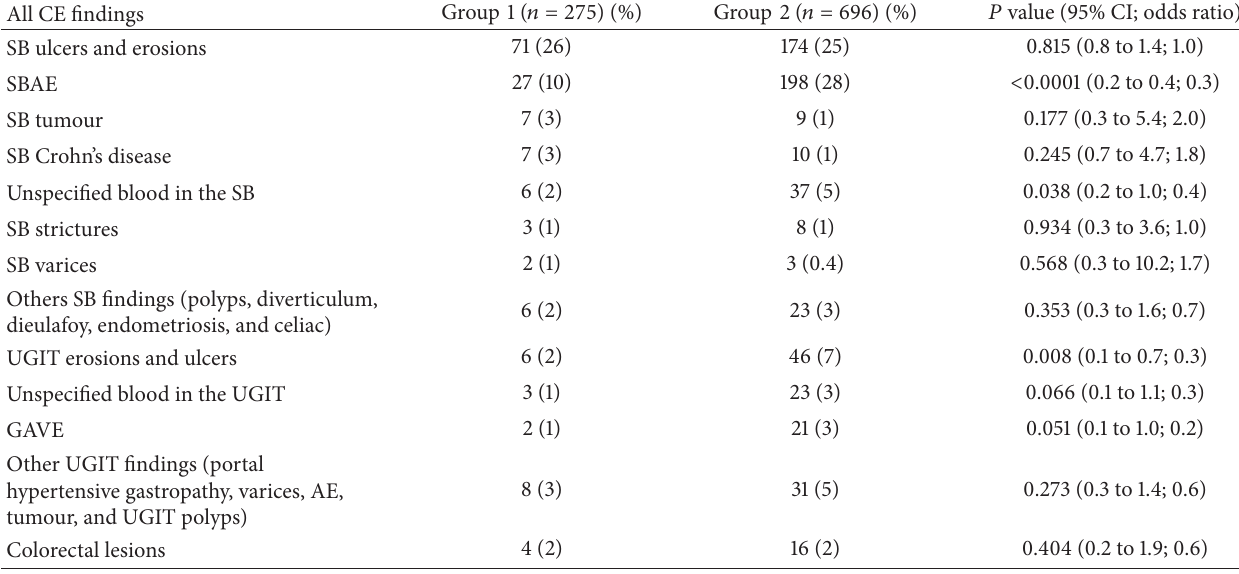
Table 1: Distribution of all the findings on capsule endoscopy in patients < 50 and ≥ 50 years of age with recurrent iron deficiency anaemia. All CE